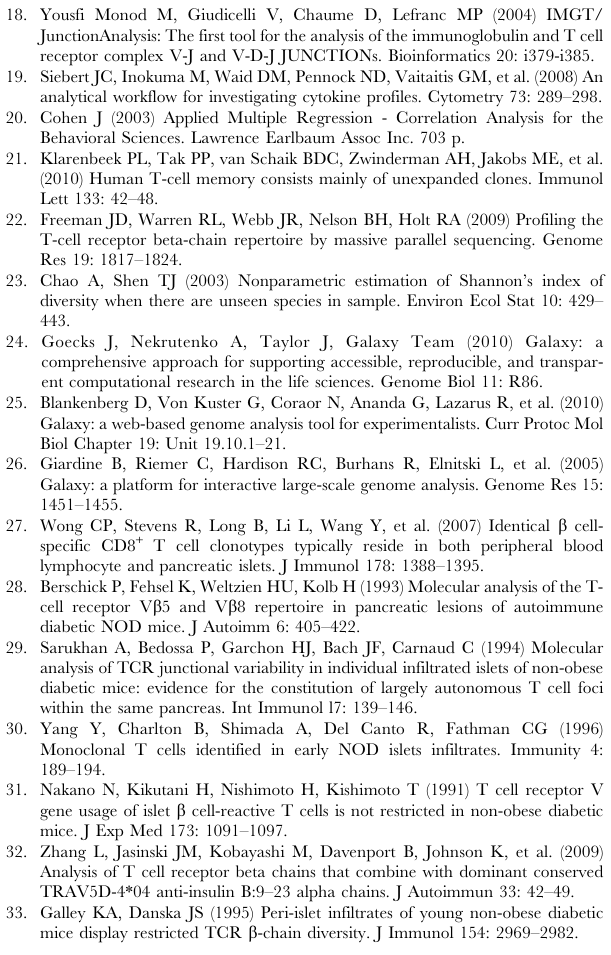
Figure S4 TRBV gene usage by islet-infiltrating CD4 + CD44 high clonotypes from individual NOD mice. The frequency of TRBV gene usage in each of the prediabetic (A) and newly diabetic (B) mice. Table S1 Frequency of TRBV gene segment usage by individual mice. The frequency of TRBV gene segment usage by total, high- frequency, and rare islet-infiltrating CD4 + CD44 high clonotypes. Table S2 Islet-infiltrating CD4 + CD44 high clonotypes shared by at least one prediabetic and one diabetic mouse. 135 clonotypes common to both groups of mice were shared by at least one mouse from each